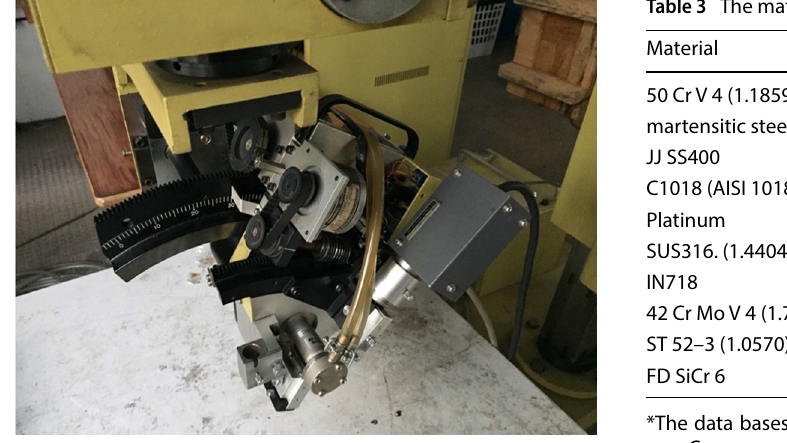
Fig. 7 Goniometer of MFS-2 M